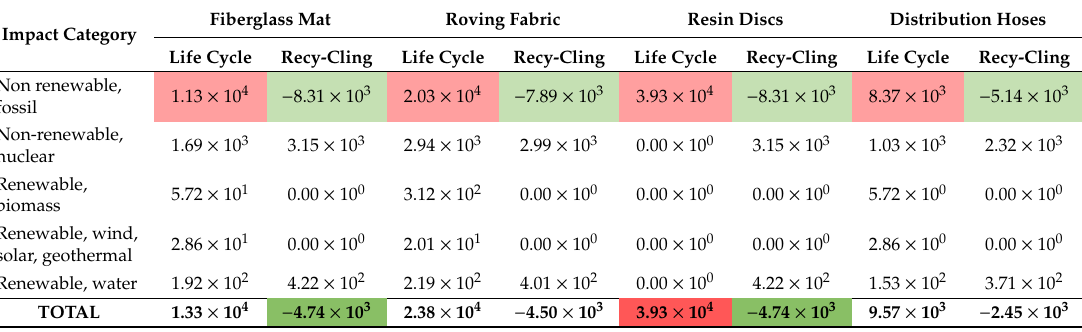
Red highlight—the highest level of negative environmental consequences for the analyzed impact categories. Green highlight—the highest level of positive environmental consequences for the analyzed impact